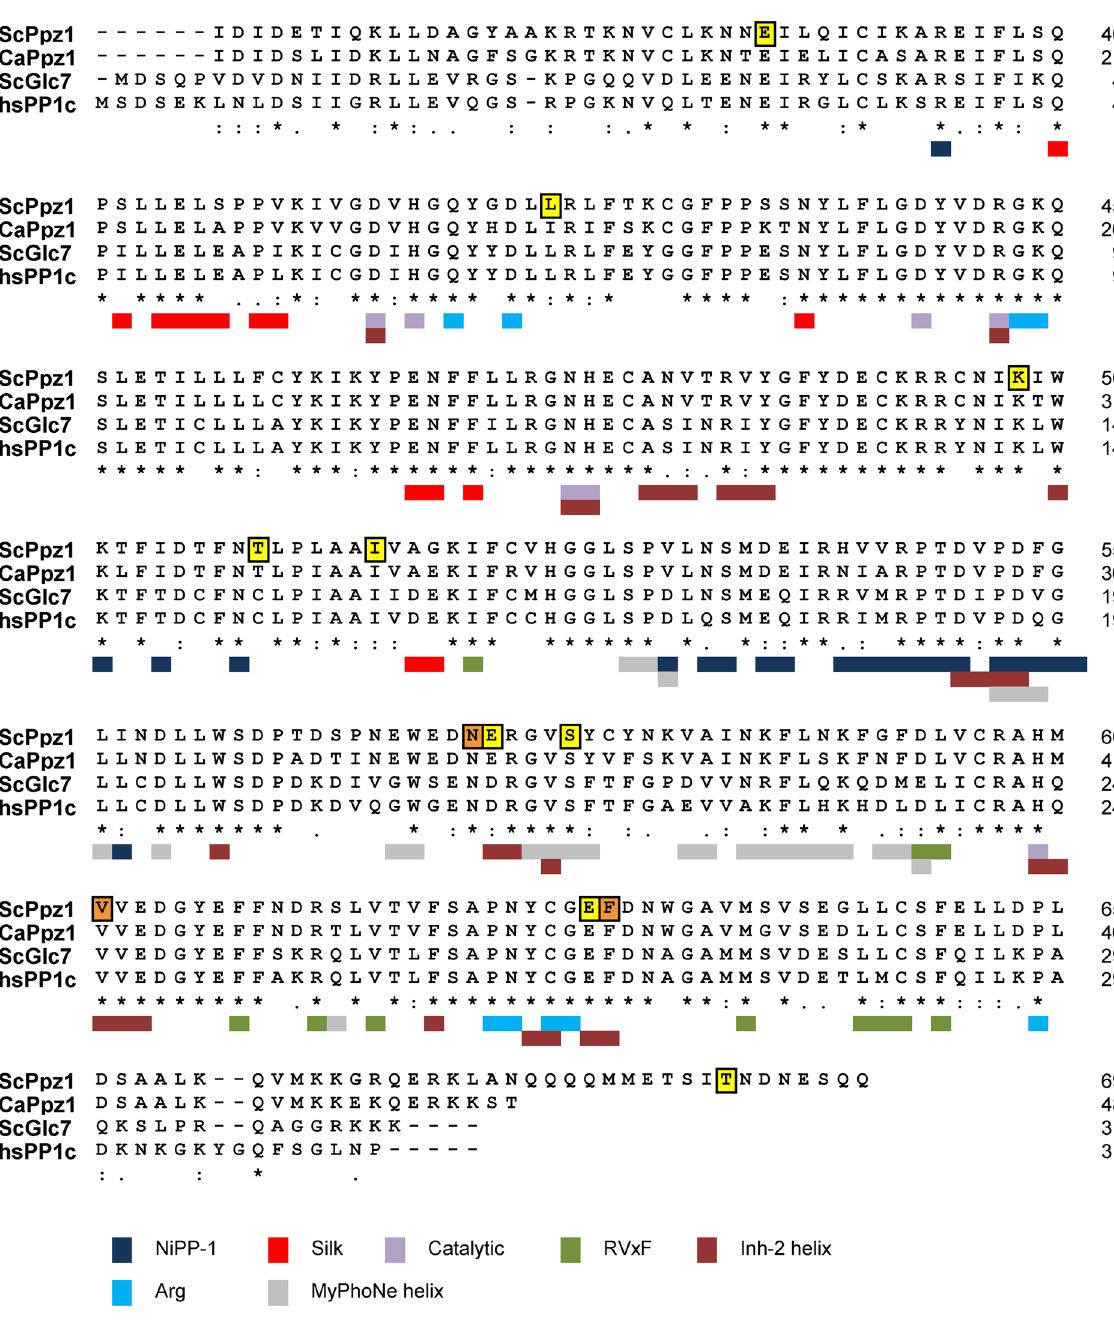
regulation of mammalian PP1c (and also yeast Glc7), very little is known about how Hal3, the major regulator of Ppz1, exerts its function. The majority (about 2/3) of PP1c (and Glc7) regulators are proteins containing the so-called RVxF motif 30 , which binds to a hydrophobic groove whose structure is strongly conserved in Ppz1 (see Figs 7 and 8). There are a number of observations supporting the notion that the RVxF-binding motif is also functionally conserved in Ppz1. For instance, in vivo interactions between Ppz1 and two Glc7 regulatory subunits displaying RVxF motifs, Glc8 and Ypi1, has been reported by 2-hybrid experiments 27 . Interaction between Ppz1 and Ypi1 was also